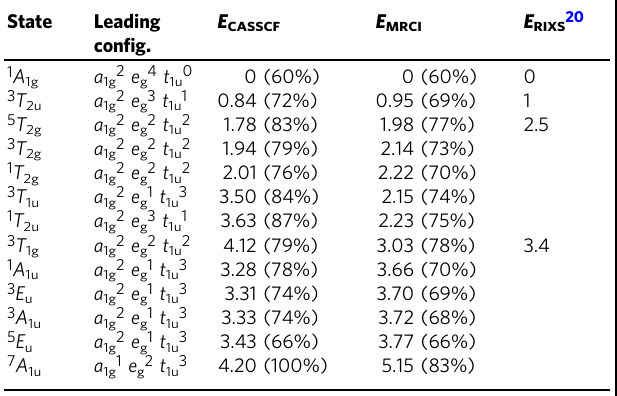
Table 2 Excitation energies (eV) for a B 6 2 − octahedral block in YbB 6 (CAS(6,6) reference). Leading con fi g.